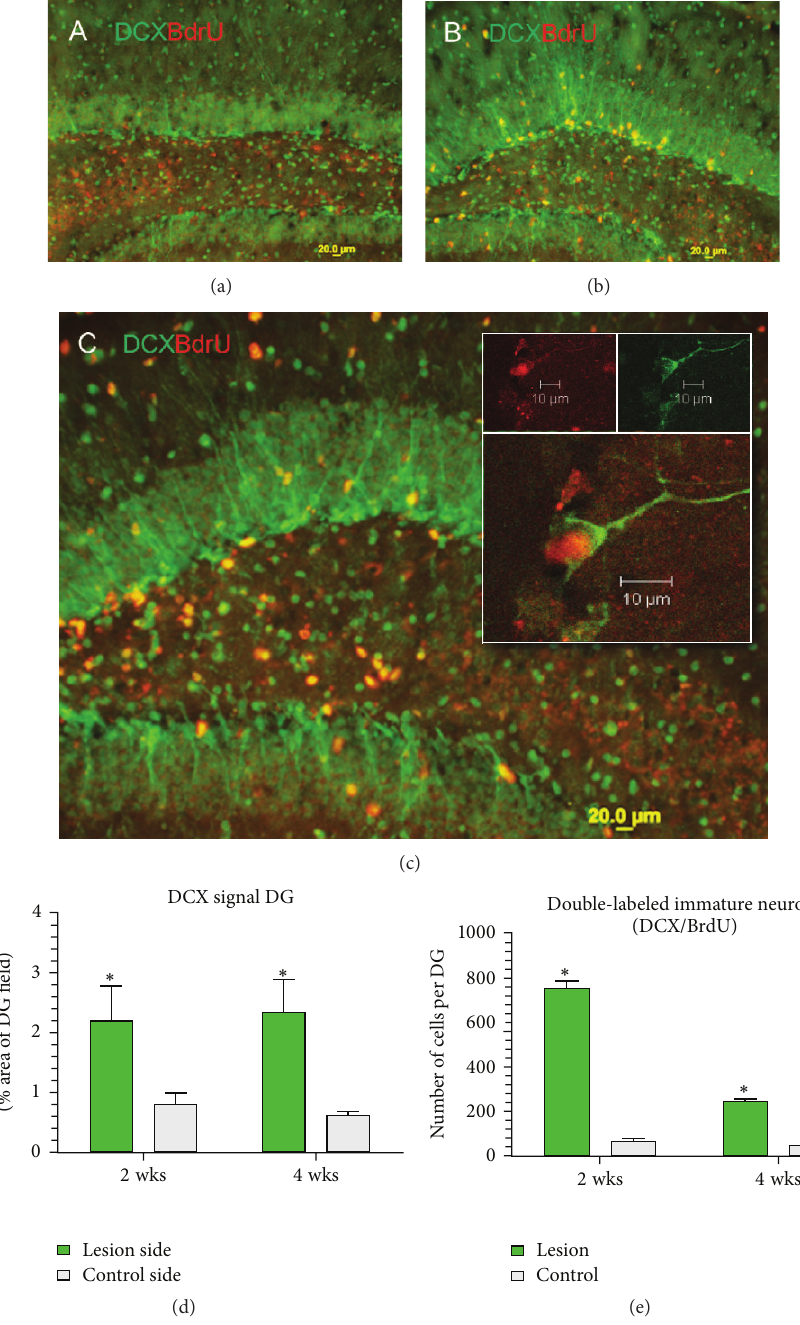
Figure 5: Microlesion stimulates neurogenesis. (a) Merged image of DCX and BrdU immunoreactive cells on the unlesioned control side (2wks after the lesion). (b) Lesioned side illustrates increased DCX and BrdU (merged image). (c) Same as panel (b), but magnified; scale bar = 20 𝜇 m. Doublecortin (DCX) Immunoreactive cells in the subgranular zone of the dentate gyrus extend processes into the granular zone. The box inserted in (c) depicts confocal images of double-labeled DCX-BrdU cell at a higher power. Upper two panels are isolated for DCX (green) and BrdU (red) immunofluorescence, and the lower panel is the merged image (scale bar = 10 𝜇 m). (d) Summary data of DCX signal expressed as percent of DG field. Lesioned side exhibits a significantly increased DCX signal compared to control at both 2 and 4wks after the microlesion. Unlike microgliosis and astrocytosis, the DCX signal does not decline after 4wks. (e) Cell counts of double-labeled immature neurons (DCX/BrdU) born within 2 days of lesion placement. The lesion significantly increased birth of new neurons compared to unlesioned control side. 𝑃 < 0.001 . However, the number of double-labeled cells was significantly less at 4wks than observed at